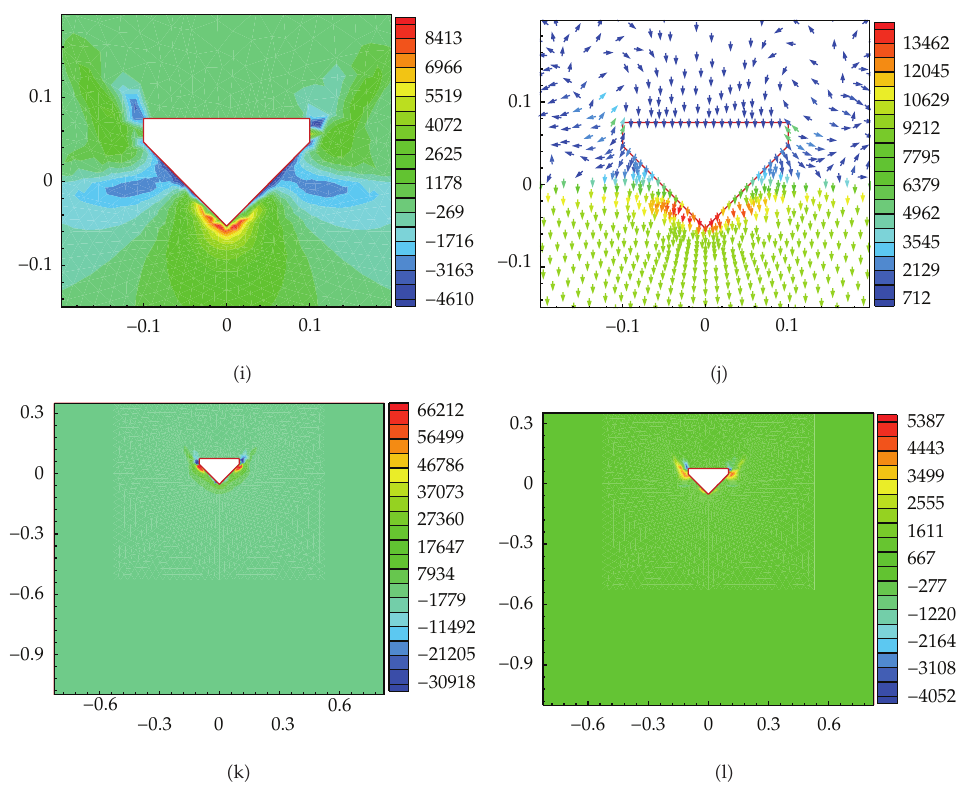
Figure 11: Microscopic details of fluid energy at t (cid:9) 0 . 18s. (cid:2) a (cid:3) free surface profile; (cid:2) b (cid:3) velocity vector; (cid:2) c (cid:3) convection of kinetic energy; (cid:2) d (cid:3) convective vector of kinetic energy (cid:2) high to low (cid:3) ; (cid:2) e (cid:3) work done by pressure; (cid:2) f (cid:3) convective vector of pressure; (cid:2) g (cid:3) work done by gravity; (cid:2) h (cid:3) gravity vector; (cid:2) i (cid:3) convection of potential energy; (cid:2) j (cid:3) convective vector of potential energy; (cid:2) k (cid:3) transient change of kinetic energy; (cid:2) l (cid:3) transient change of potential